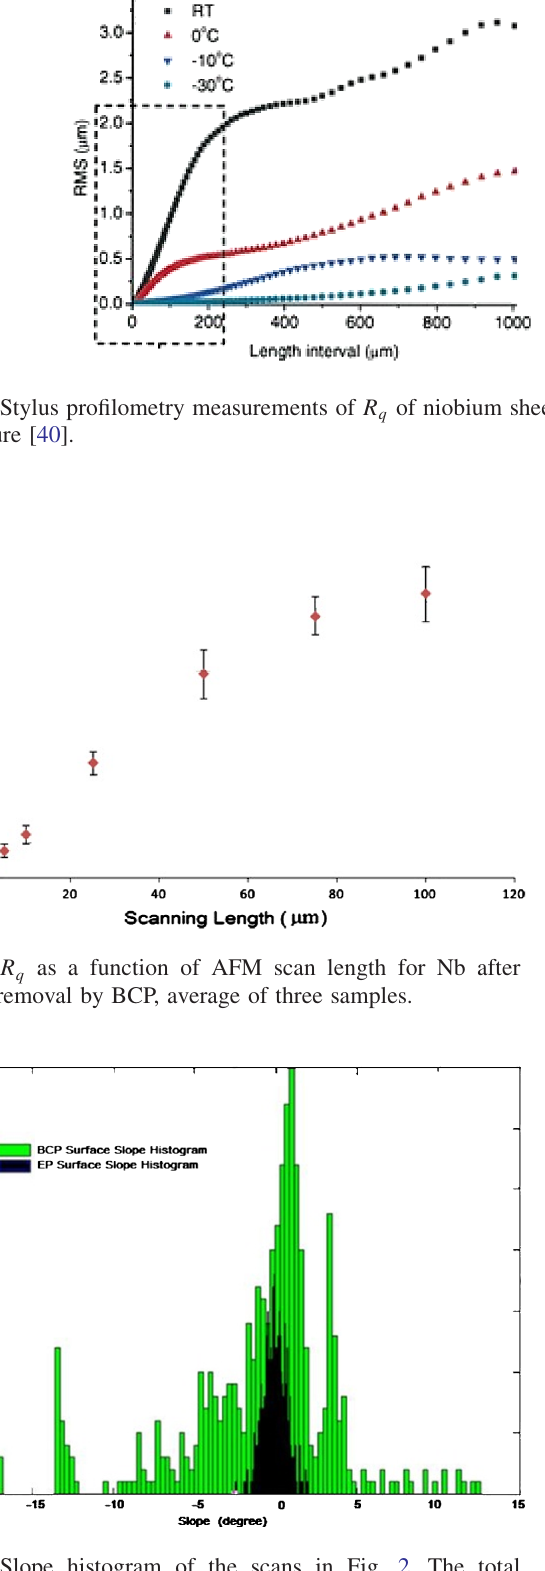
FIG. 6. Slope histogram of the scans in Fig. 2. The total scanning point number is 262144. The bin for BCP is 0.25 (cid:2) and bin width for EP is 0.05 (cid:2) .